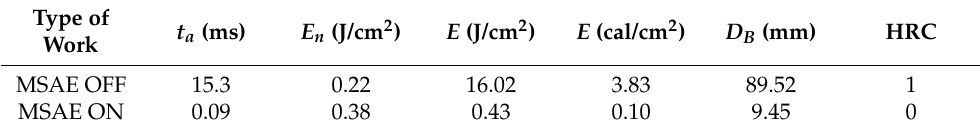
Table 5. The results of calculating the arc energy, flash protection boundary, and hazard risk category for the experiment without MSAE (MSAE OFF) and in the system with MSAE (MSAE ON). Type of t a (ms) Work MSAE OFF MSAE